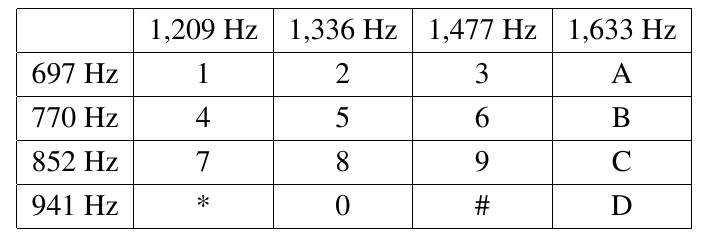
Table 1. DTMF frequencies pairs and corresponding digits. Adapted from the Audio Engineer’s Reference Book